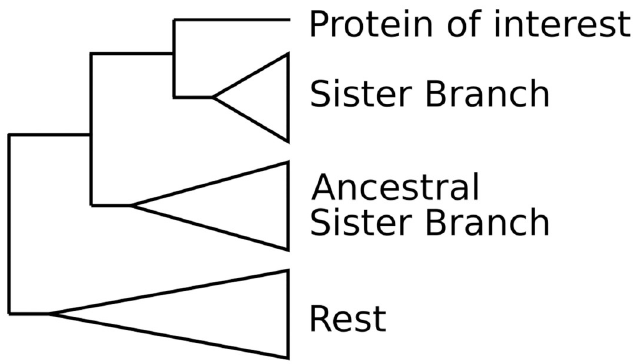
Fig 2. Tree example. Sister branch positions on the phylogenetic tree.